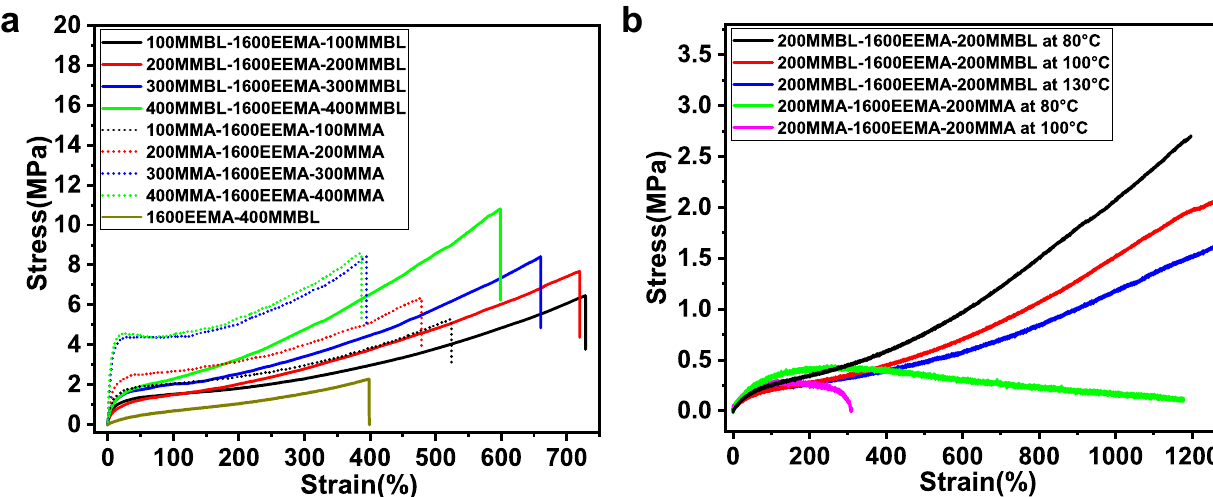
Fig. 7 Mechanical performance. a. Comparison of the stress − strain curves of different ratios of PMMBL-based TPEs with those of PMMA-based TPEs at RT. b Comparison of the stress − strain curves of PMMBL-based TPEs with those of PMMA-based TPEs at high temperatures (80 – 130 of [MMA] 0 , the [(BHT) 2 AlMe] 0 /[ μ Hex [P(NI i Pr)Ph] 2 ] 0 ratio was